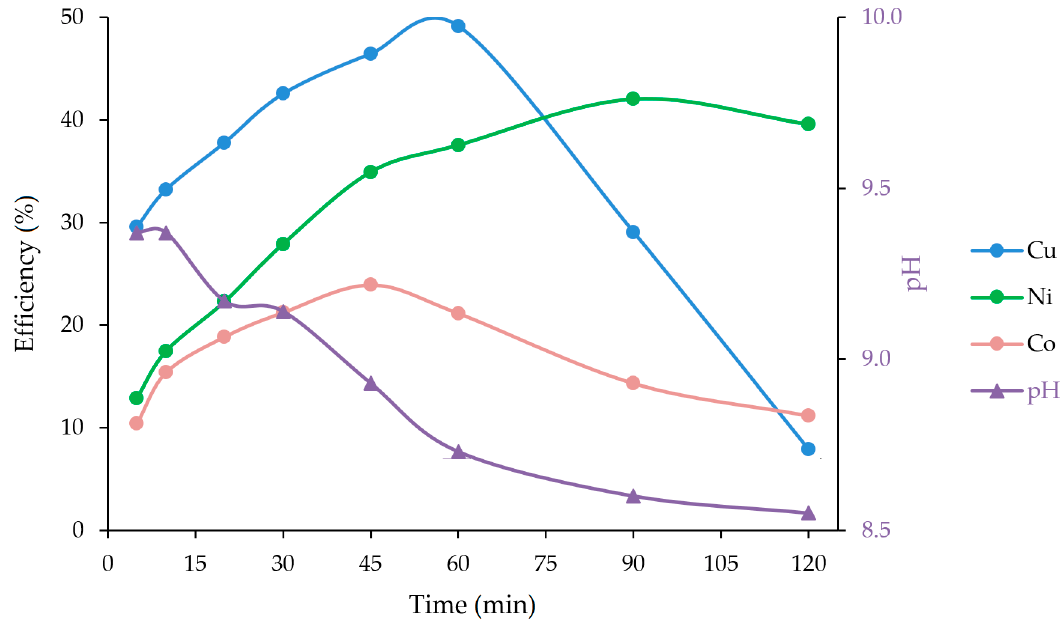
Figure 3. Kinetics of metals extraction during ammoniacal leaching at 85 ◦ C.